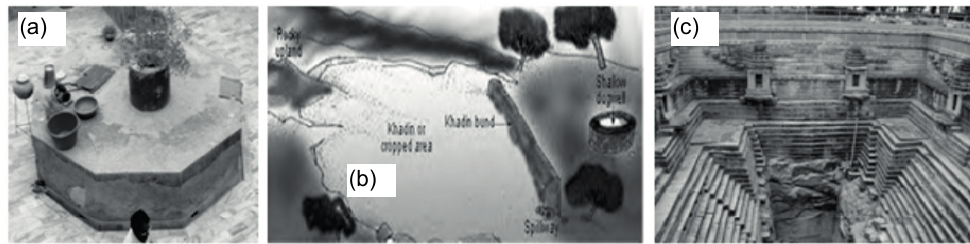
Fig. 2 (a) Tanka, (b) Khadin, (c)